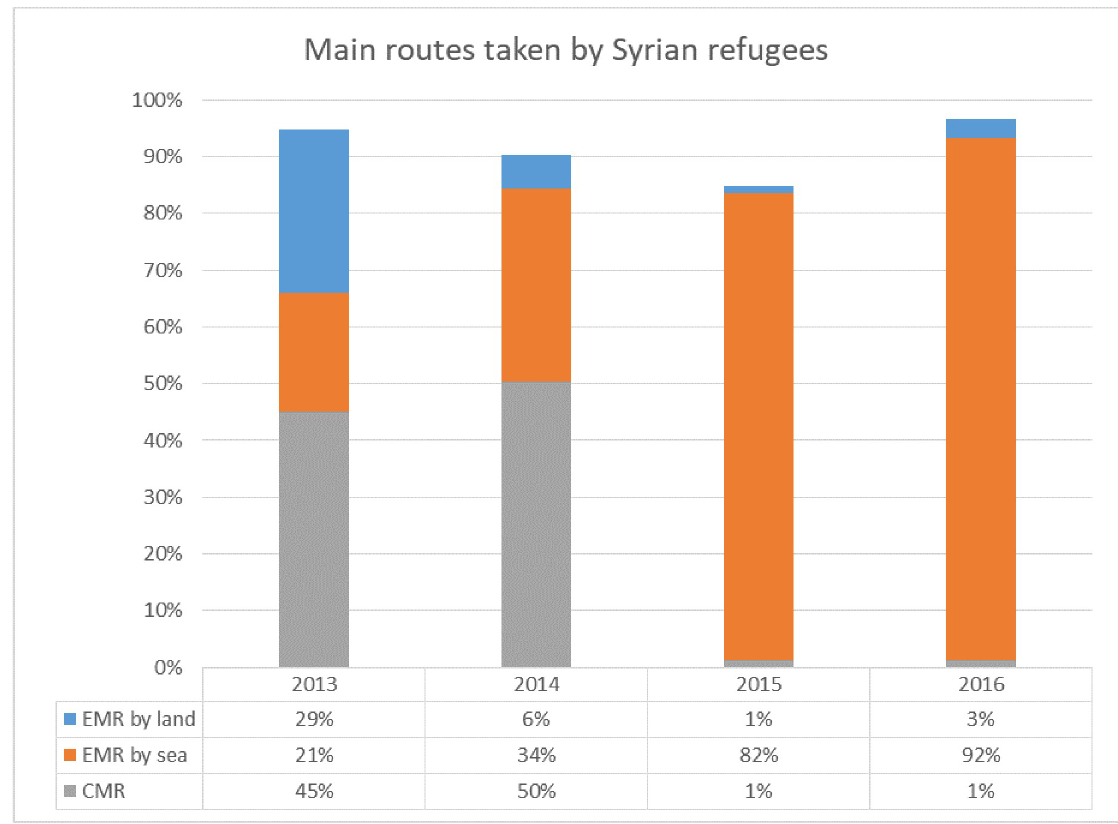
Fig 3. Illegal border crossings detected by Frontex (Syrians only) of three main routes. Central Mediterranean Route (grey), Eastern Mediterranean Route by sea (orange) and Eastern Mediterranean Route by land (blue). Source: [17].